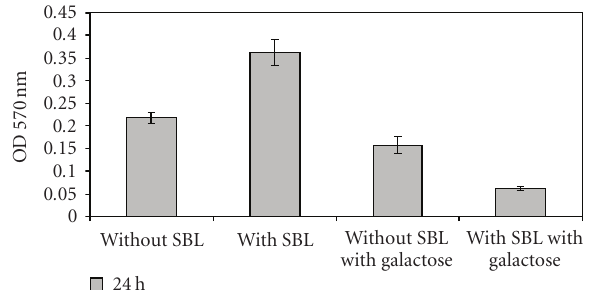
Figure 5: Optical density at 570 nm indicating biofilm formation in the microtiter plate assay by B. japonicum USDA 110 with or without 300 μ g ml − 1 SBL and/or 100 mM galactose at 24-hours incubation